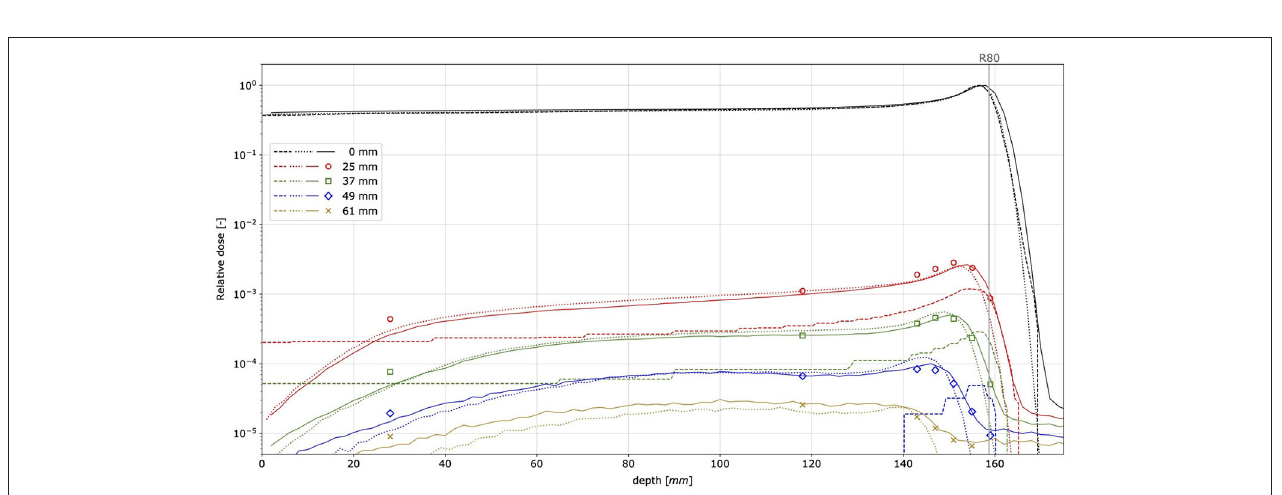
FIGURE 7 | Longitudinal pencil beam dose profiles measured in water for proton beam nominal energy E150. Points correspond to M INI P IX T IMEPIX measurement results, whereas for solid, dotted, and dashed lines, they correspond to GATE /Geant4, FRED , and TPS simulations, respectively. The mean proton range of 158.7mm is marked by a vertical line